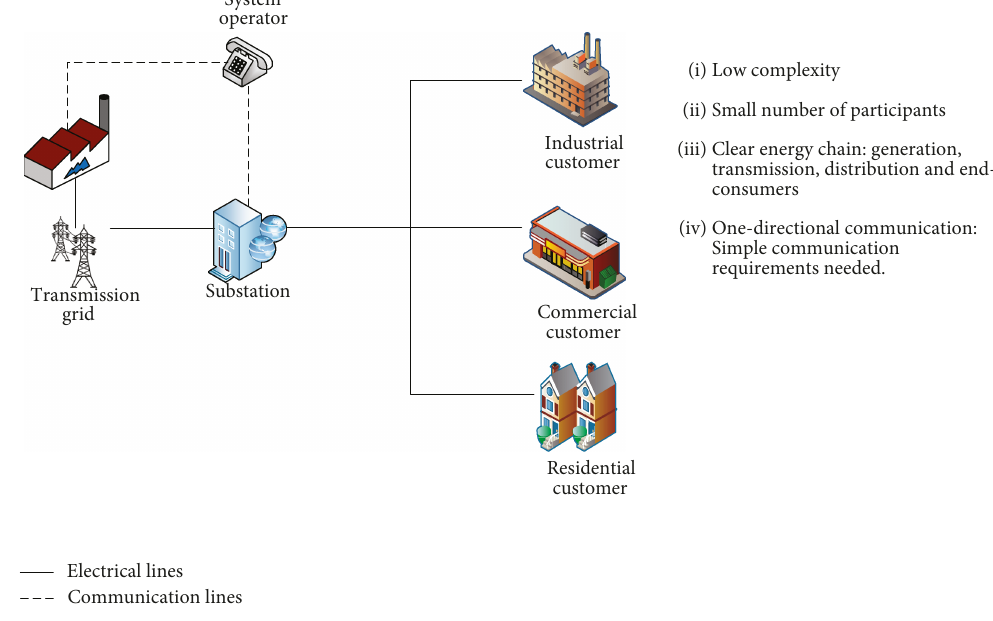
Figure 1: The past of the electricity system. One of the greatest inventions of the 20th